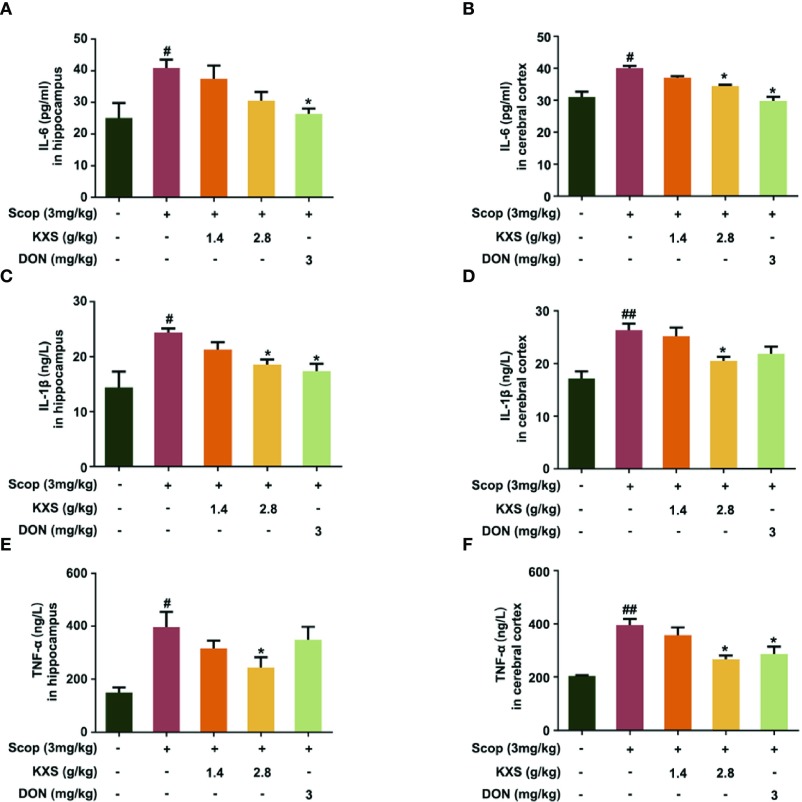
Kai-Xin-San (KXS) attenuates inflammatory injury in scopolamine (SCOP)-induced mice. The levels of interleukin (IL)-6, IL-1β, and tumor necrosis factor (TNF)-α in the hippocampus (A, C, E) and cortex (B, D, F) were determined by ELISA. Data are expressed as means ± SEM. Difference was calculated using one-way ANOVA followed by Dunnett's post hoc test (n=5, #P < 0.05, ##P < 0.01 the control group versus the SCOP group; *P < 0.05 versus the SCOP group).